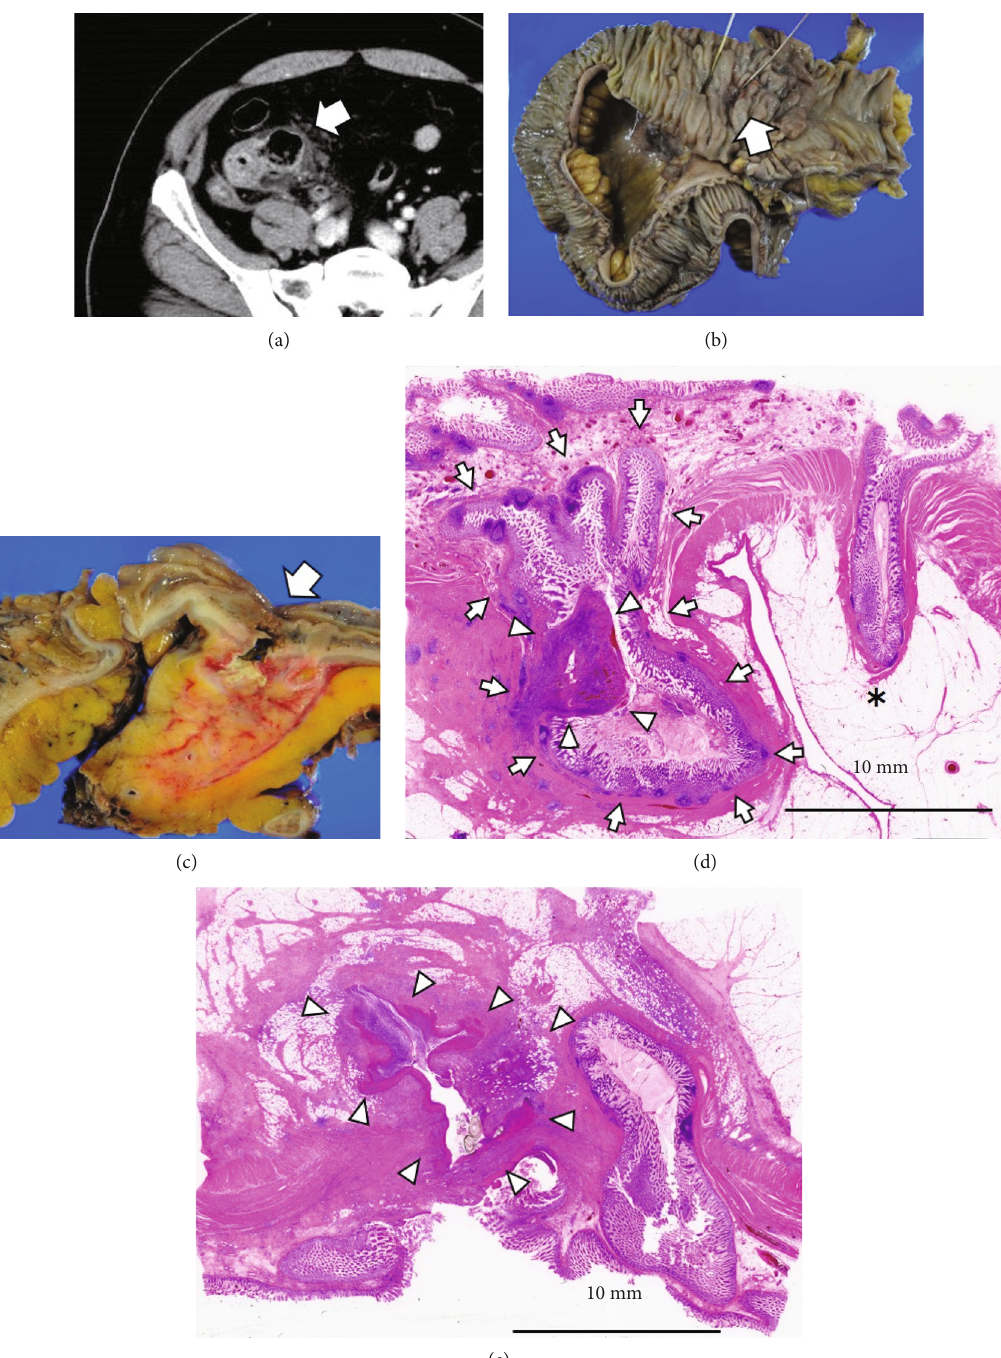
Figure 1: Case 1 fi ndings. (a) Contrast-enhanced CT revealed the in fl ammation of mesenterium caused by penetration of a terminal ileac 2- cm diverticulitis (arrow). The CT detected air in the terminal ileum ’ s mesentery. However, no free air was detected in the abdominal cavity. (b) Resected specimen postileocecal resection revealed at least two diverticulum. Two surgical bougie probes show diverticulum of specimens. (c) Specimen cross section of penetration from diverticulitis (arrow). (d) Histological (H&E) evaluation of the diverticulum mucosa. In fl ammatory granuloma (arrowheads) was observed in the diverticulitis (arrow). An additional diverticulum was detected (asterisk). (e) Histologically (H&E), we observed severe in fl ammatory fi ndings